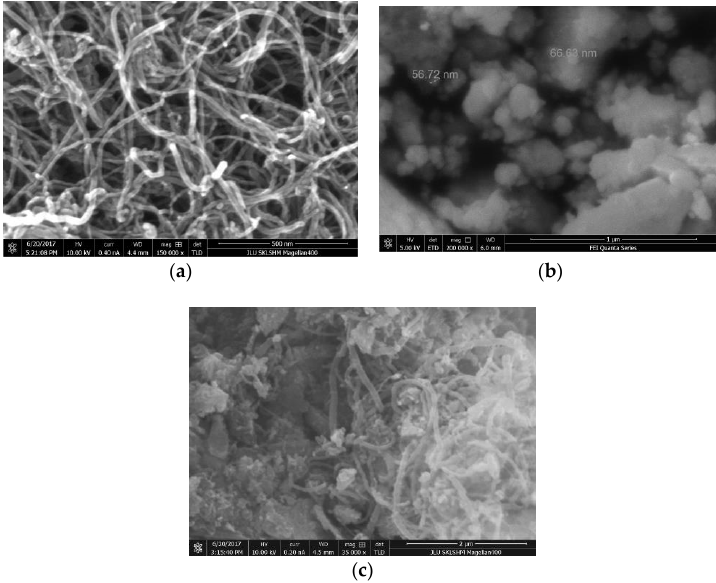
Figure 5. SEM analysis of the sensor carrier materials. ( a ) SEM of multiwalled carbon nanotubes (MWNTs). ( b ) SEM of the Al 2 O 3 carrier particles. ( c ) SEM of the MWNTs mixed with the Al 2 O 3 carrier.